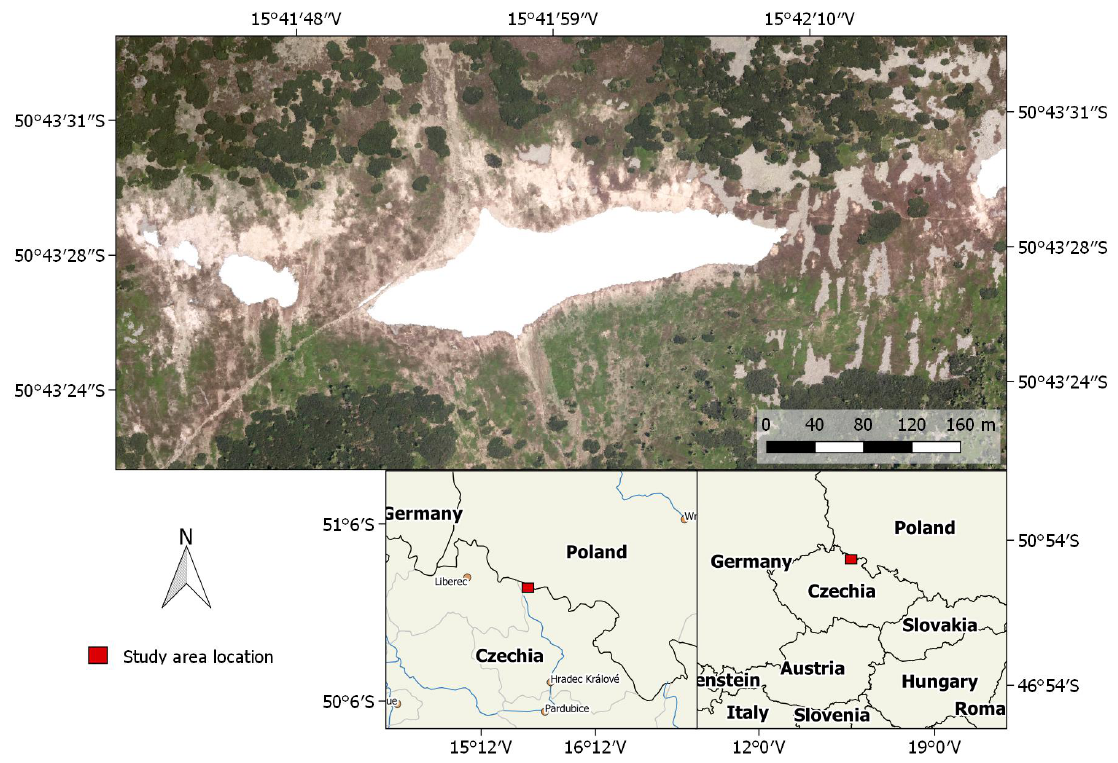
Figure 1. The study site location (the orthophoto obtained during the melting season 2012).